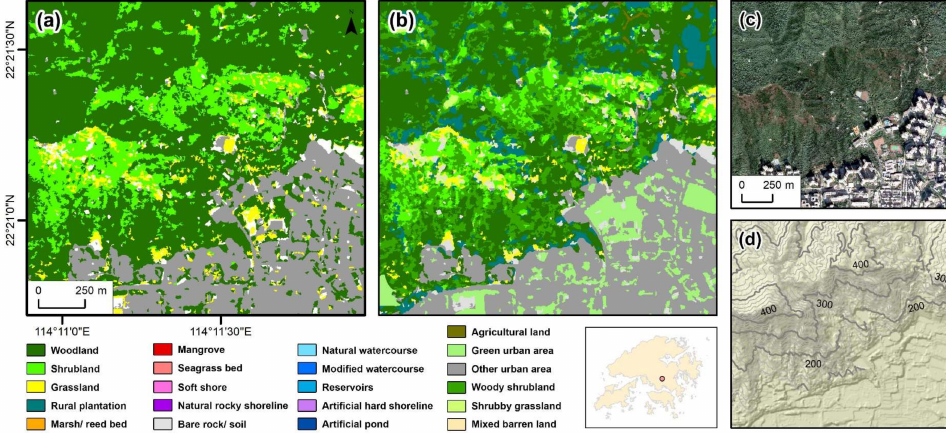
Figure 6. A selected area of habitat map showing the results before and after applying the modification rules in stage 3; ( a ) classification map with 10 classes in stage 2 produced using pixel-based RF method; ( b ) habitat map with 21 classes in stage 3; ( c ) true-colour composite of the WorldView image; ( d ) topographic map of the same